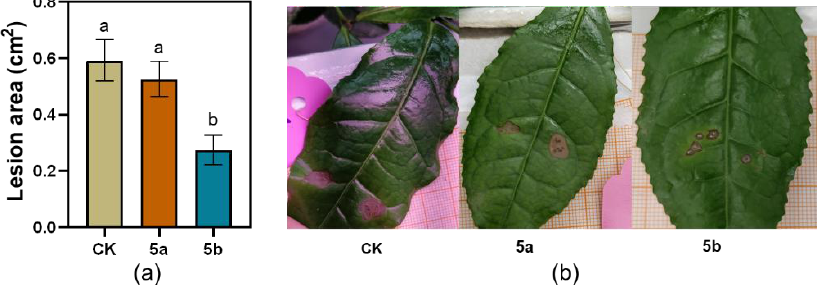
Figure 2. Effect of JA-Ile-macrolactones on the infection of Colletotrichum camelliae . ( a ) Mean lesion area of C. camelliae on tea plants (±SE, n = 12), different letters indicate significant differences among treatments ( p < 0.05, Turkey’s test ); ( b ) Photos of the infections.